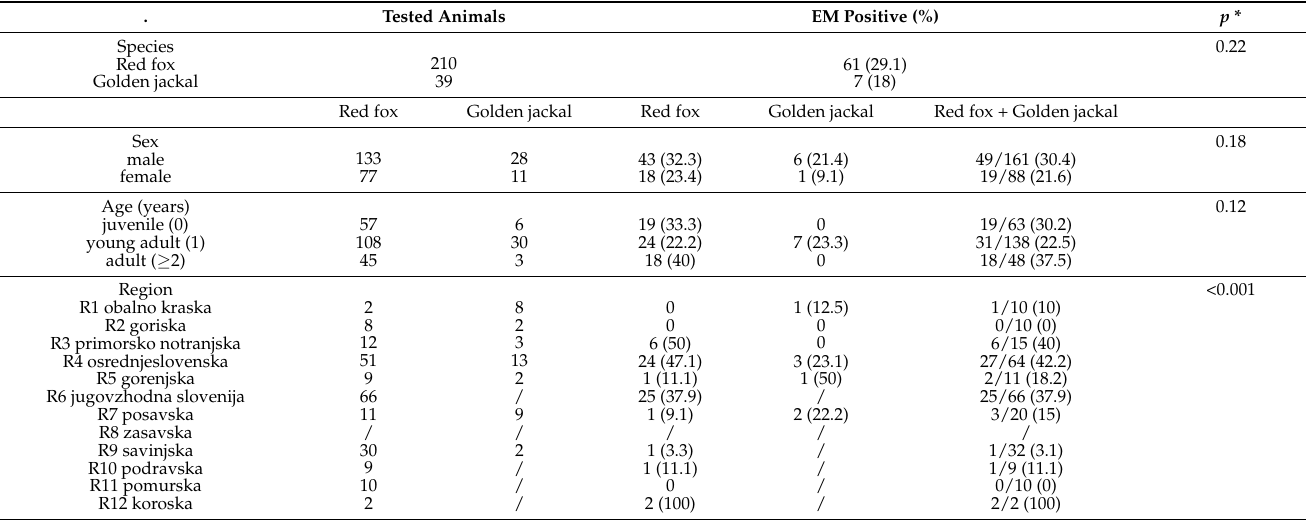
Table 2. Prevalence of E. multilocularis in red fox and golden jackal populations by species, sex, age, and region.